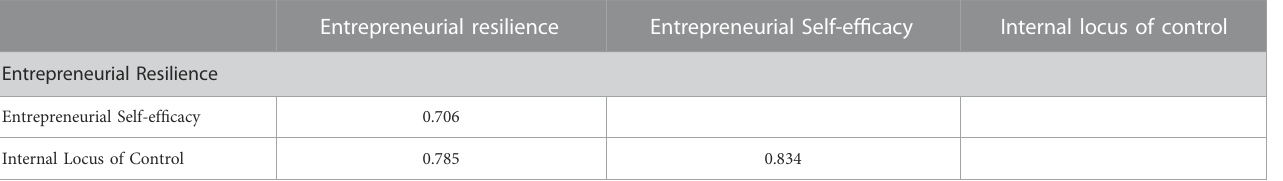
TABLE 2 Heterotrait-monotrait ratio